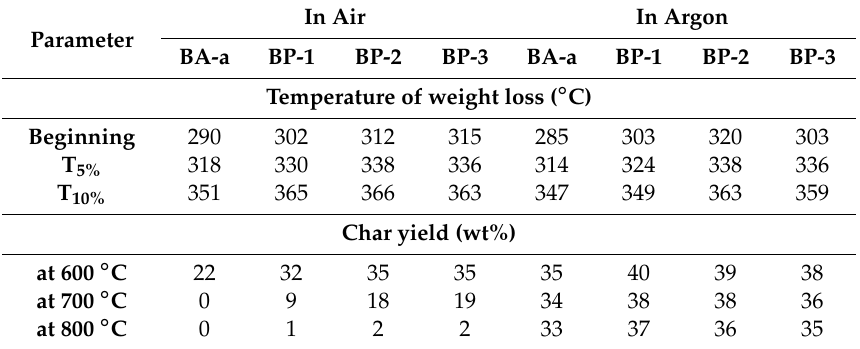
Table 6. The results of thermogravimetric analysis of polymers based on BA-a and phosphazene- containing